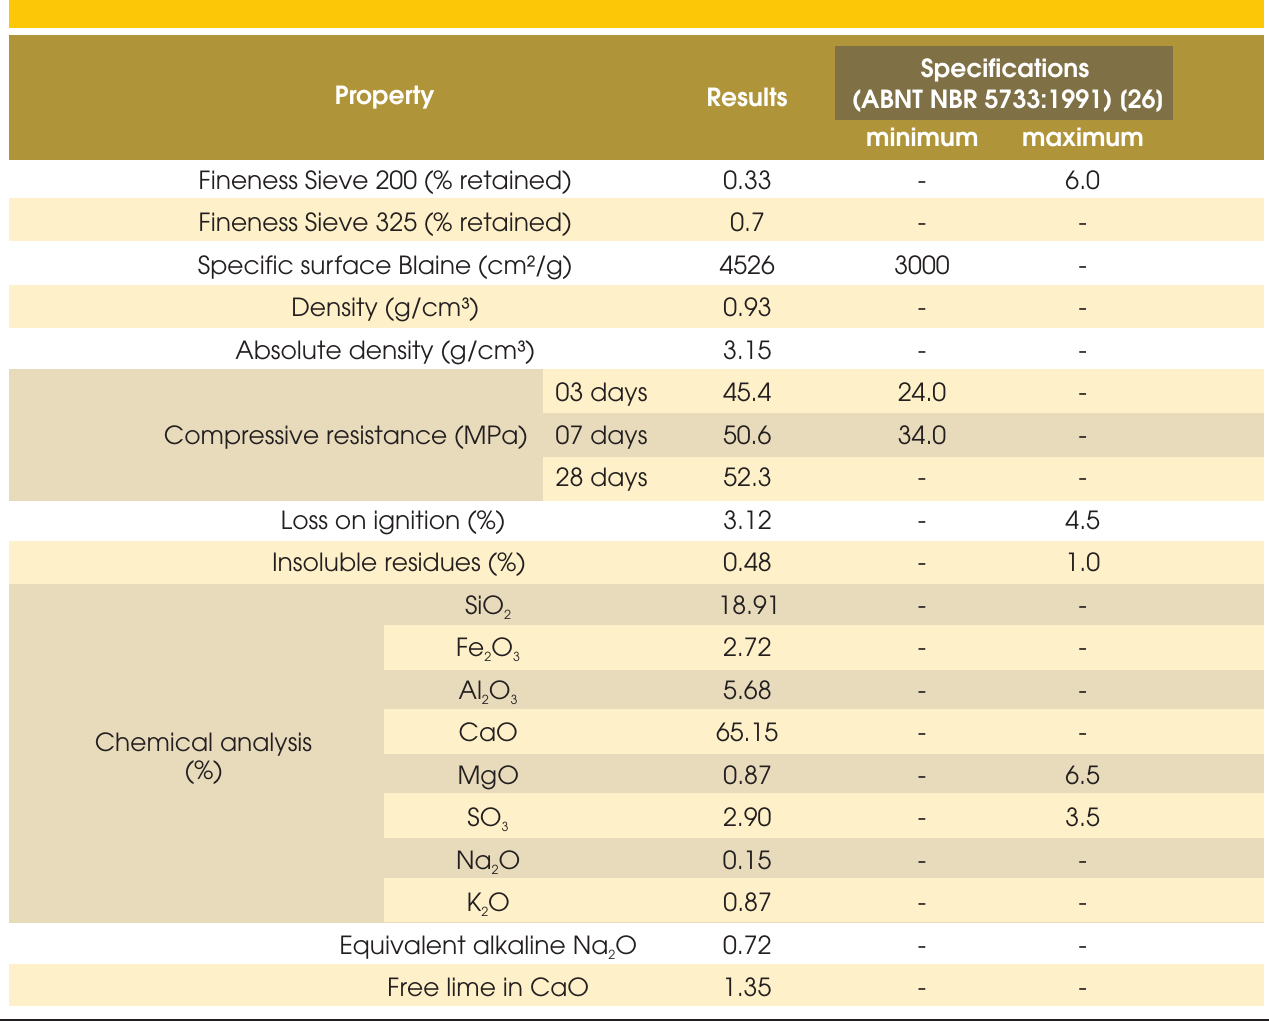
Table 1 – Physicochemical parameters of cement CPV ARI used